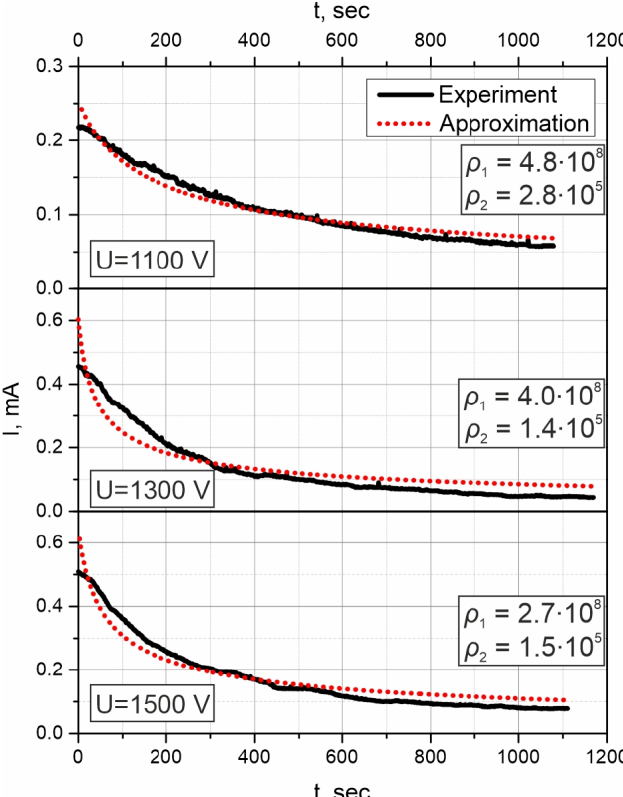
Figure 6. Polarization current dependencies on time (solid curves) for samples poled under 1100 V ( upper ), 1300 V ( middle ) and 1500 V ( lower ) and fitting curves (dotted). Values of resistivities ρ 1,2 (in Ohm∙m) providing the best approximation are indicated near the curves.